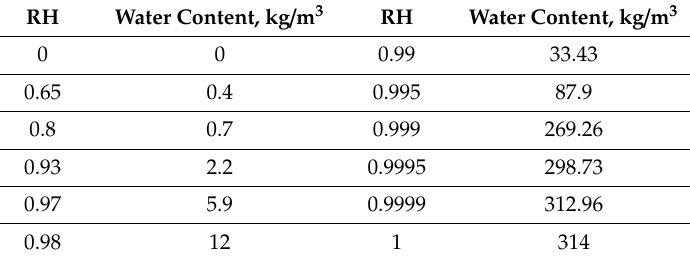
Table A9. Moisture storage